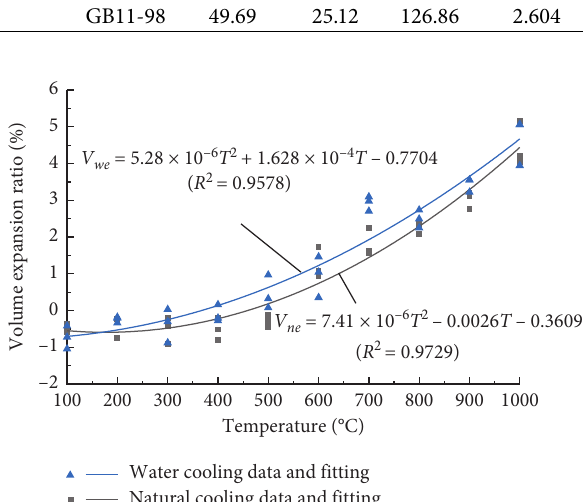
Figure 4: Mass loss rate of high temperature sandstone after two cooling